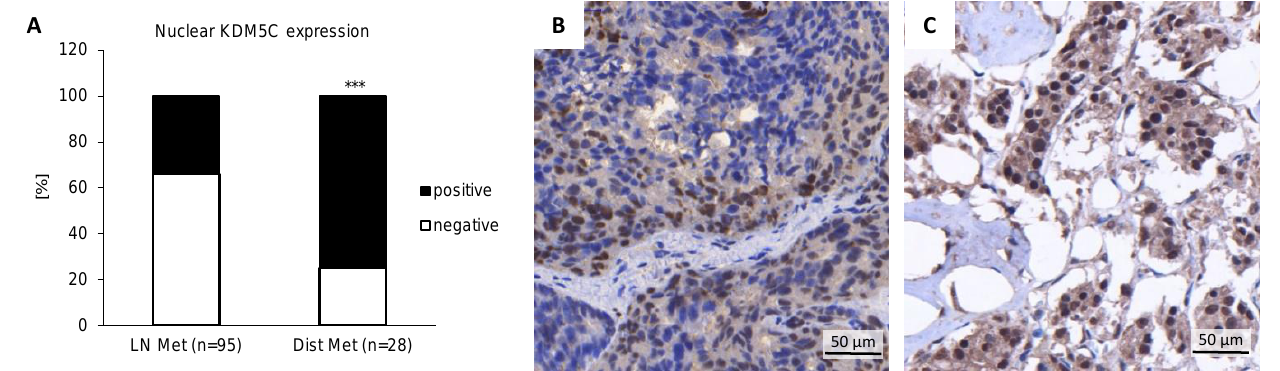
Figure 1. Immunohistochemical staining of KDM5C in a prostate cancer progression cohort. ( A ) Nuclear KDM5C expression in lymph node (LN) metastasis and bone (Dist) metastasis; ( B ) Representative sample of KDM5C protein expression in an invasive tumor edge in lymph node metastasis; ( C ) Representative sample of KDM5C protein expression in bone metastasis showing strong nuclear staining in tumor cells. (*** = p < 0.001).